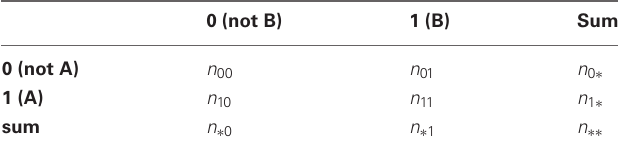
Table 1 | A 2 × 2 contingency table for binary events A and B . FIGURE 1 | Accretion example: (A) Spikes of four neurons N = { a , b , c , d }